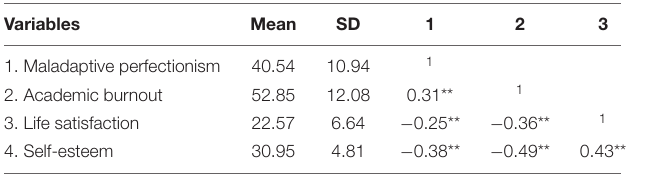
TABLE 1 | Means, standard deviation (SD) and correlations of psychological